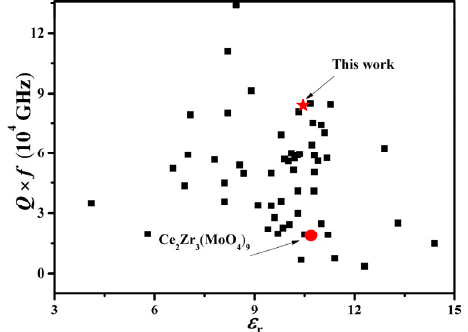
Fig. 8 Q × f with ɛ r of Mo-salt microwave dielectric